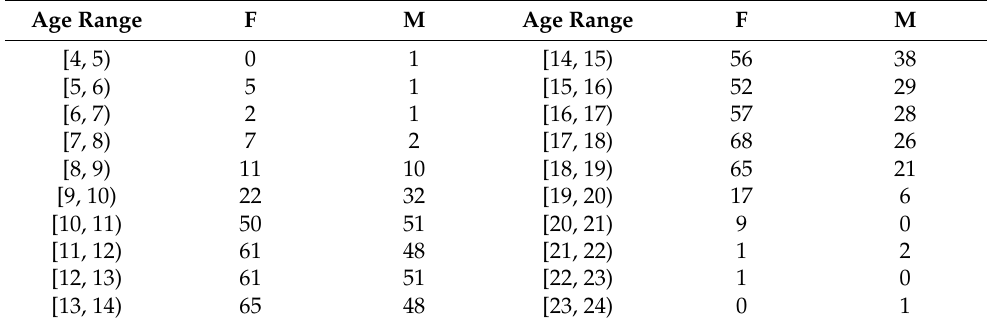
Table 4. Demographic characteristics.